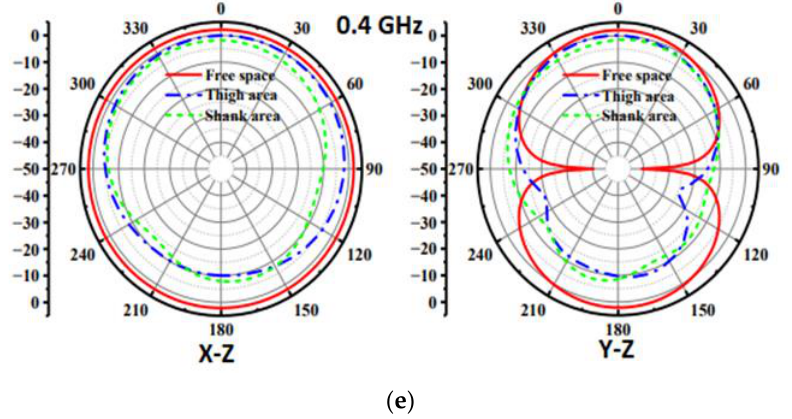
Figure 8. ( a ) Fabricated UWB antenna. ( b ) S11 of the antenna. ( c ) The antenna loaded on the different positions of the voxel model. ( d ) S11 of the loaded antenna. ( e ) Radiation pattern. Reprinted ( a – e ) from Ref. [62].